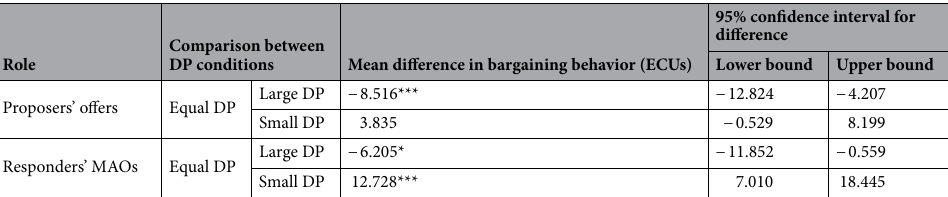
Table 1. Comparison of bargaining behavior across power conditions. * p < 0.05. ** p < 0.01. *** p <